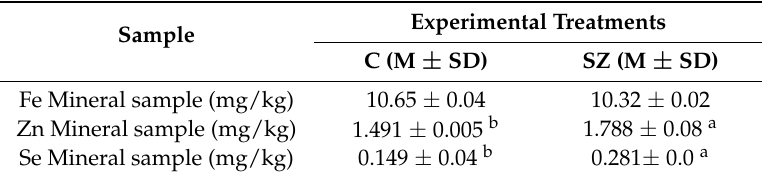
Table 3. Initial mineral concentration in